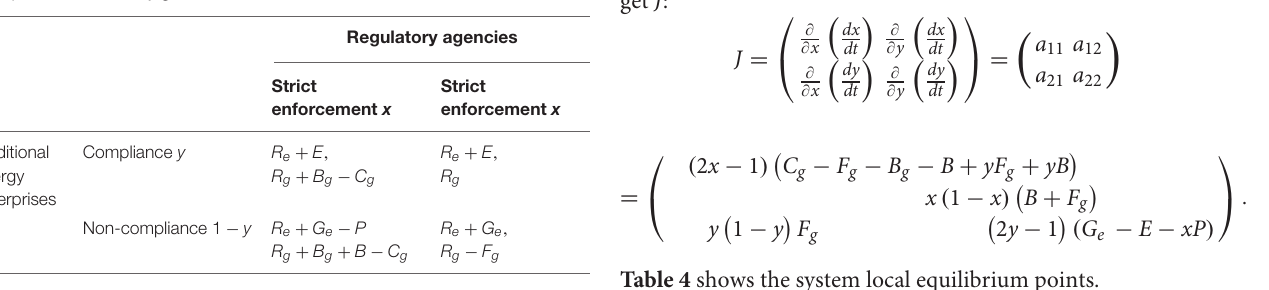
TABLE 3 | Payoff matrix of the regulatory agencies’ and traditional energy enterprises’ evolutionary game.